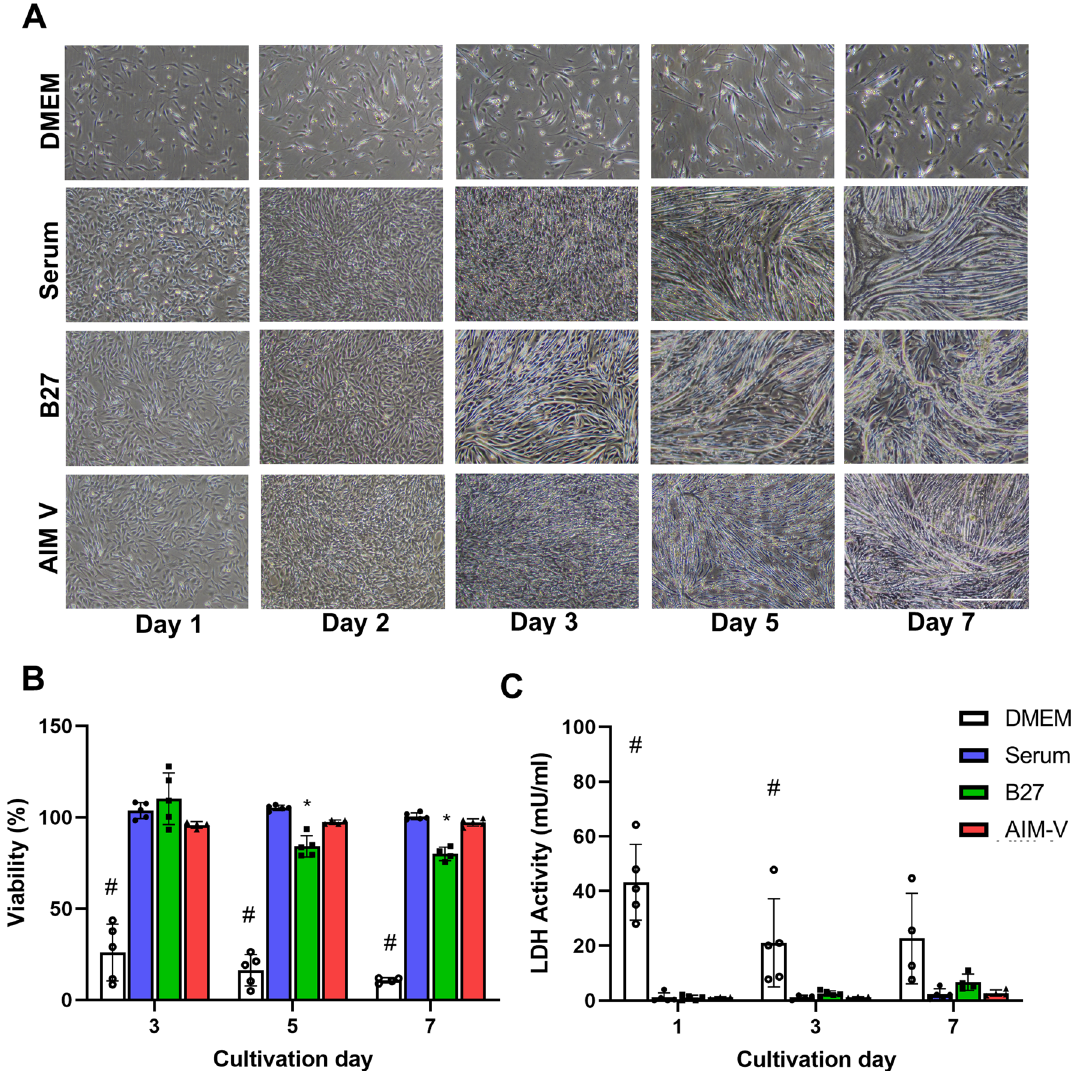
Figure 2. ( A ) Phase-contrast images of cell morphology during 7 days of cultivation in the different mediums. Myoblasts proliferation until the 2nd day of cultivation then myogenic differentiation was initiated from the 3rd day of cultivation. Fully differentiated myotubes were formed on 7th day of cultivation. Scale bar indicates 500 µm. ( B ) Cell viability based on Prestoblue assay was performed for 7 days of cultivation. Cell viability was expressed as a relative change on day 1 of each condition. ( C ) LDH activity in the medium was measured for 7 days. (n) = 3–5 in each group. One-way ANOVA followed by Tukey’s test was performed for the multiple comparisons. *p < 0.05 versus Serum and AIM-V, #p < 0.05 versus Serum, B27, and AIM-V at each cultivation day. Data presented as average ± standard deviation